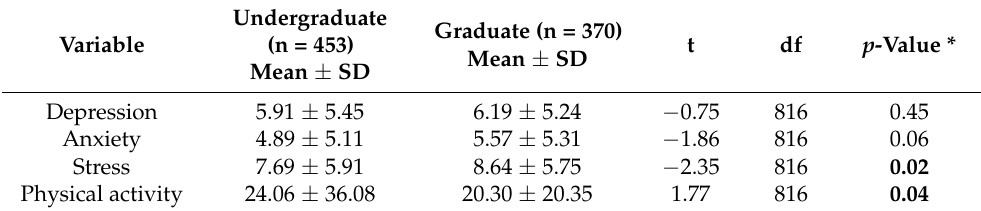
Table 9. Study program-related differences of students’ scores on the DASS-21 and the GSLTPAQ (N =